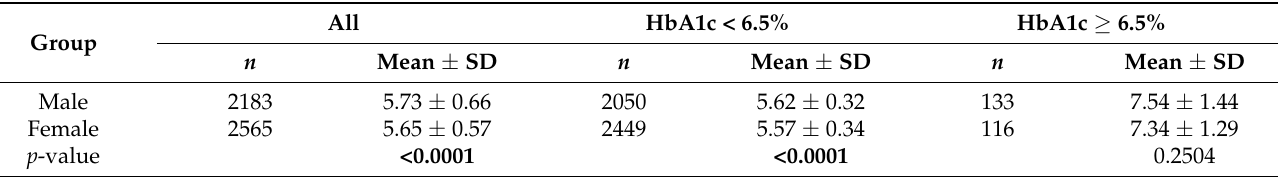
Table 4. HbA1c levels between sexes for HbA1c < 6.5% and HbA1c ≥